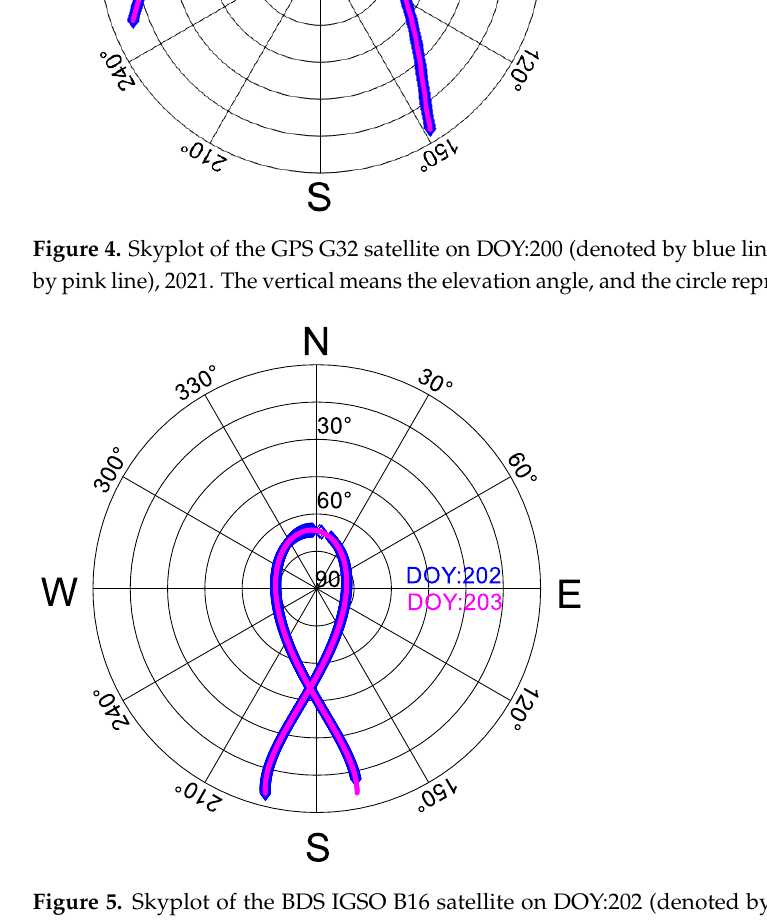
Figure 5. Skyplot of the BDS IGSO B16 satellite on DOY:202 (denoted by blue line) and DOY:203 (denoted by pink line), 2021. The vertical means the elevation angle, and the circle represents the azimuth angle.